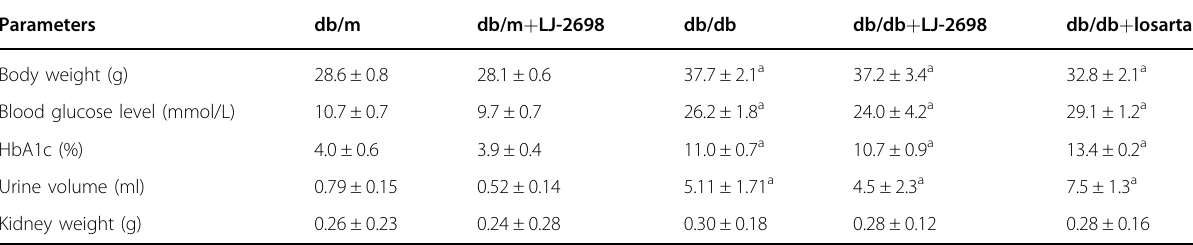
Table 3 Physical and biochemical parameters of experimental animals in experiment II